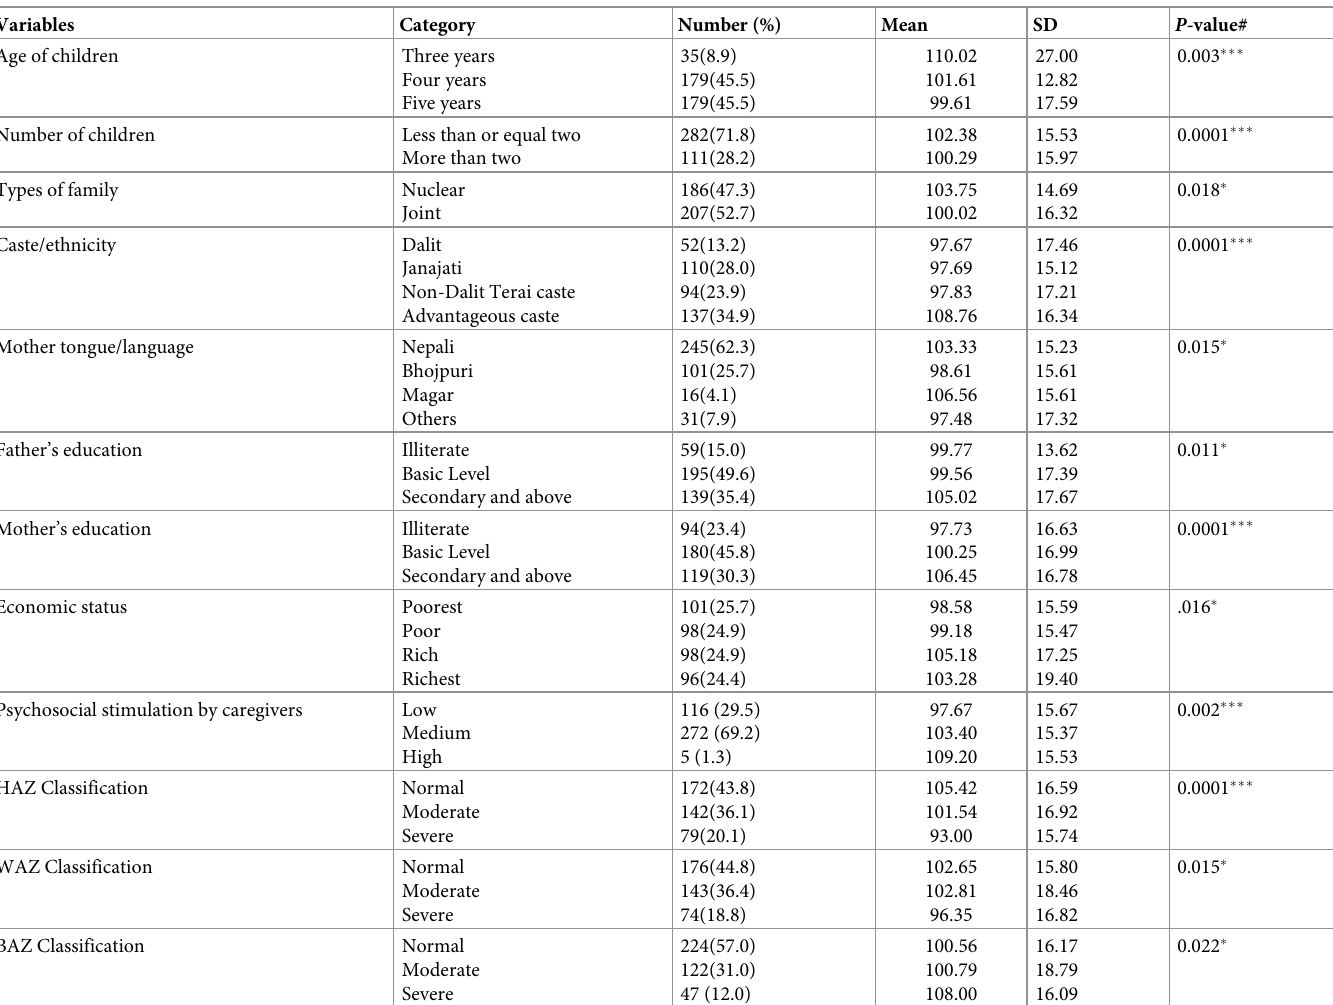
Table 2. Analysis of cognitive development with determinant factors (n =